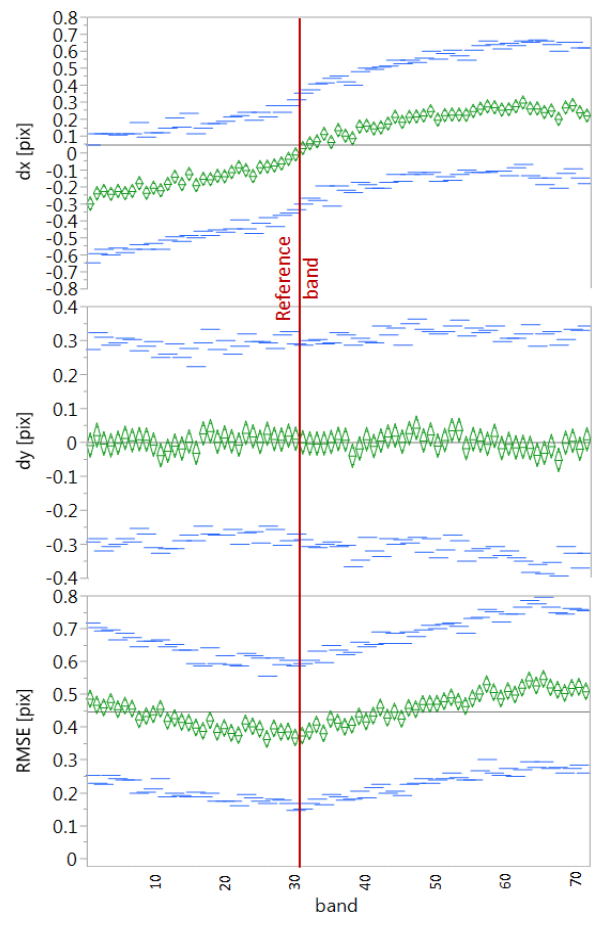
Figure 15. Average residuals (green, standard deviation marked in blue) in horizontal (dx) and vertical (dy) image direction and 2D RMSE between the reference band 31 and respective spectral